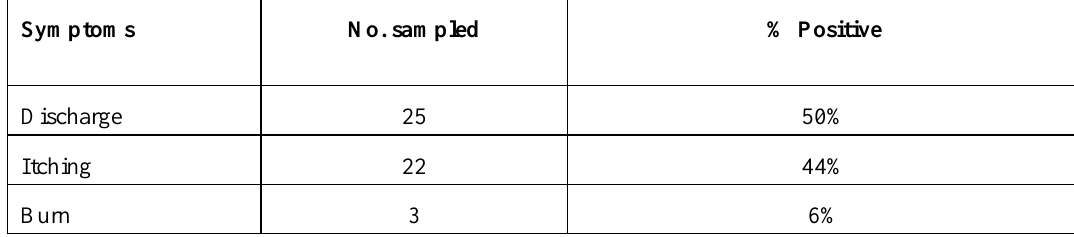
Table 4. Frequency distribution of symptoms among pregnant